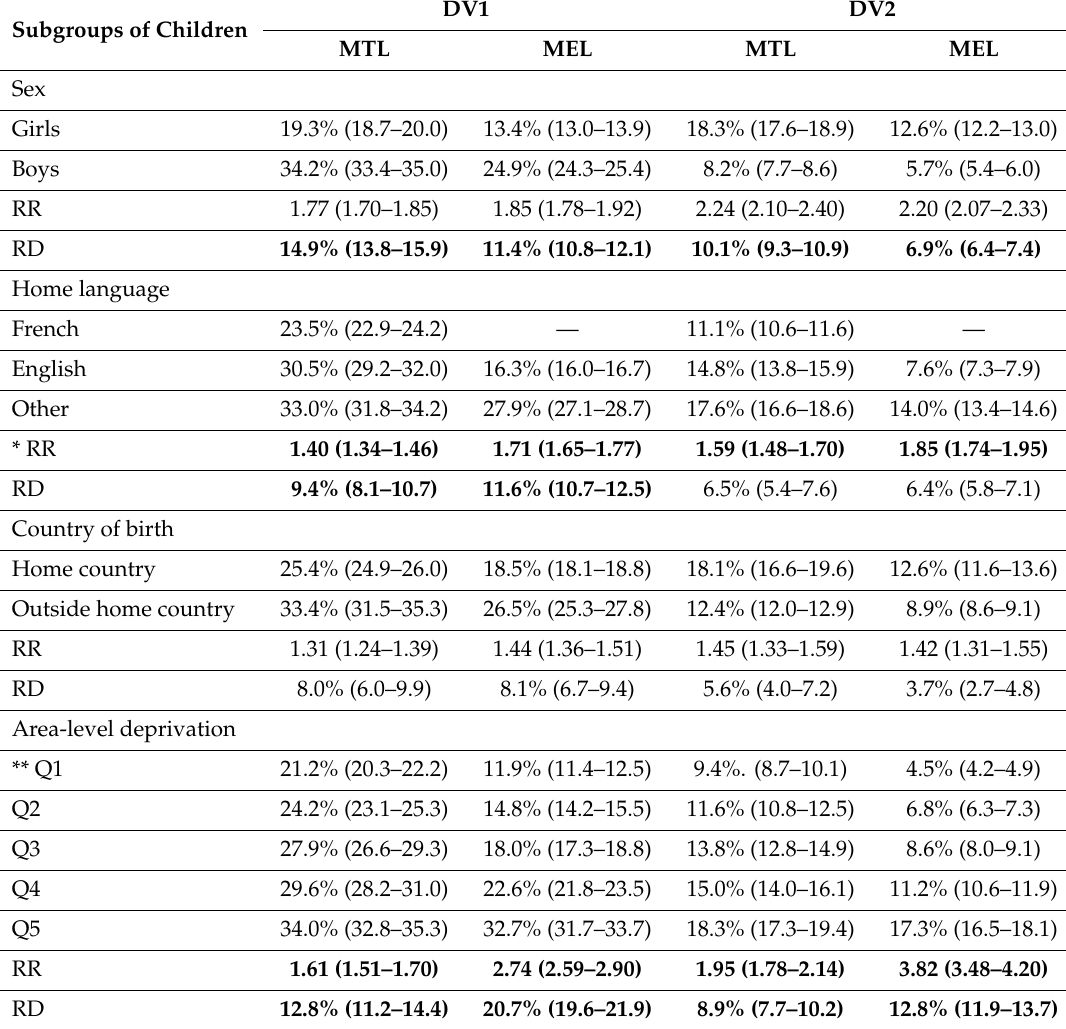
Table 5. Proportions of developmentally vulnerable children for overall indicators, relative risks and risk di ff erences across subgroups in the metropolitan Montreal and